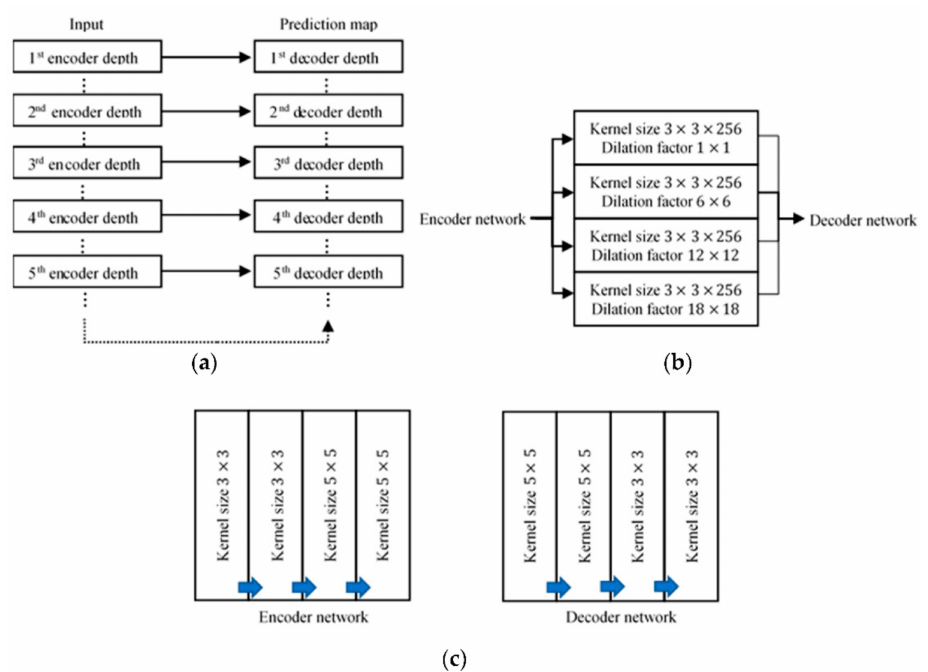
Figure 1. Modifications made to the original SegNet Visual Geometry Group-19 (VGG-19) structure: ( a ) overview of skip connections (solid arrow) introduced in our modified SegNet; ( b ) parallel dilated convolutions used at the end of the model encoder network; ( c ) the 5 × 5 kernel size convolution blocks used in our modified